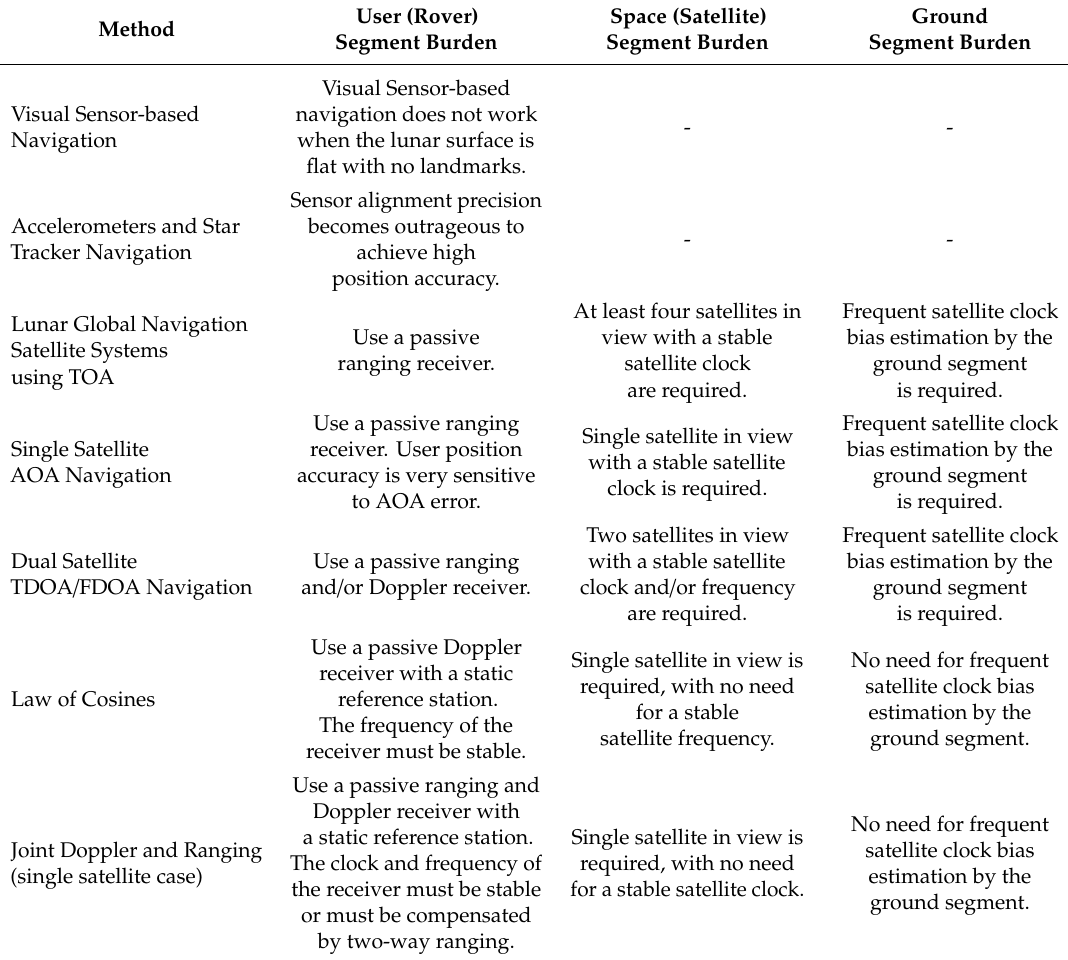
Table 1. Benchmark of navigation systems for lunar shadowed region